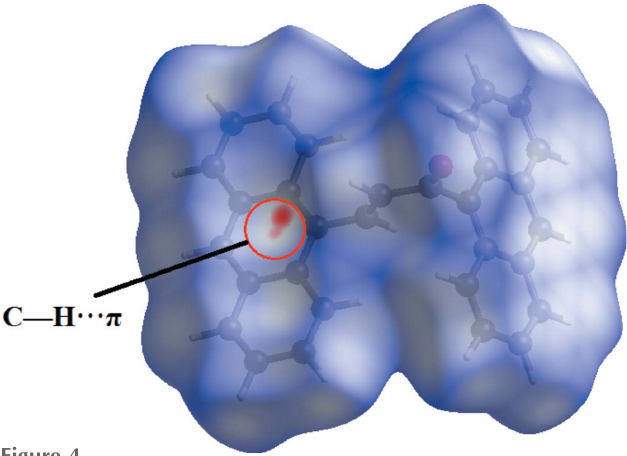
Figure 3 UV–Vis absorption spectra of (I).